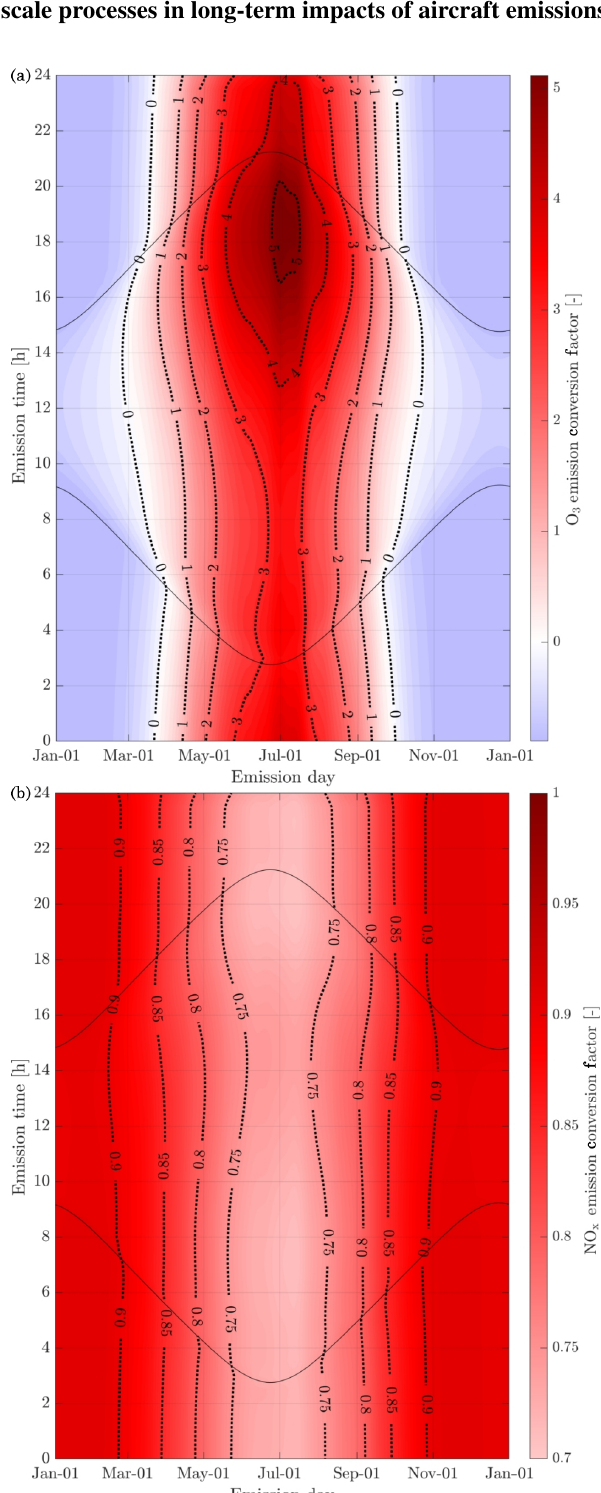
Figure 9. 24h O 3 (a) and NO x (b) emission conversion factors from the emission of a B747-8 equipped with GEnx engines at 60 ◦ N. Dotted lines represent sunrise and sunset at the given